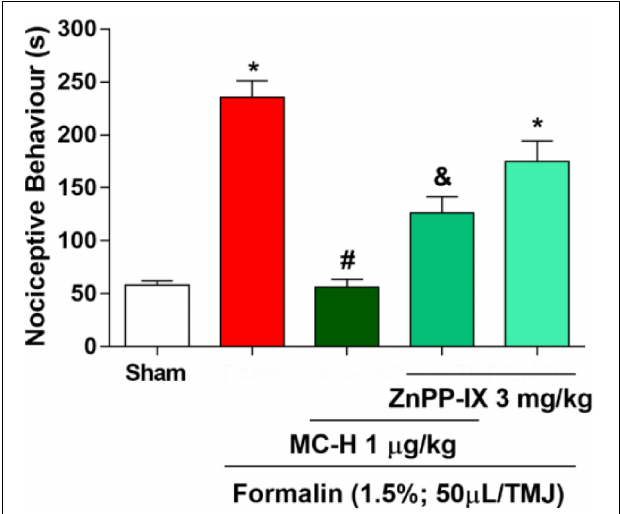
FIGURE 4 | MC-H-induced antinociception depends on heme oxygenase-1 (HO-1) integrity. Administration of MC-H (1 µ g/kg; po ) significantly decreased the nociceptive behavior induced by formalin in the TMJ. Pre-treatment with ZnPP IX (3 mg/kg), an HO-1 inhibitor, significantly decreased the antinociceptive effects of MC-H. The symbols (*), (#), and (&) represent statistically significant differences compared with saline, formalin, and MC-H groups, respectively ( p < 0.05: ANOVA, Tukey’s